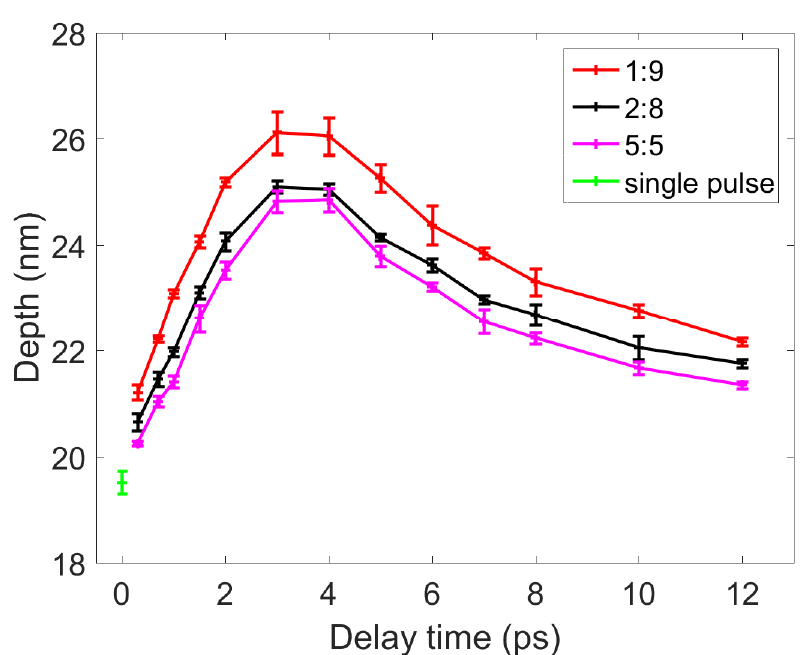
Figure 4. A comparison of the depths of the craters ablated by the double pulses (with three energy ratios) and single pulse. The red, black, and pink lines represent the results obtained for double pulses with energy ratios of 1:9, 2:8, and 5:5, respectively. The downward green triangle represents the results obtained for the single pulse.